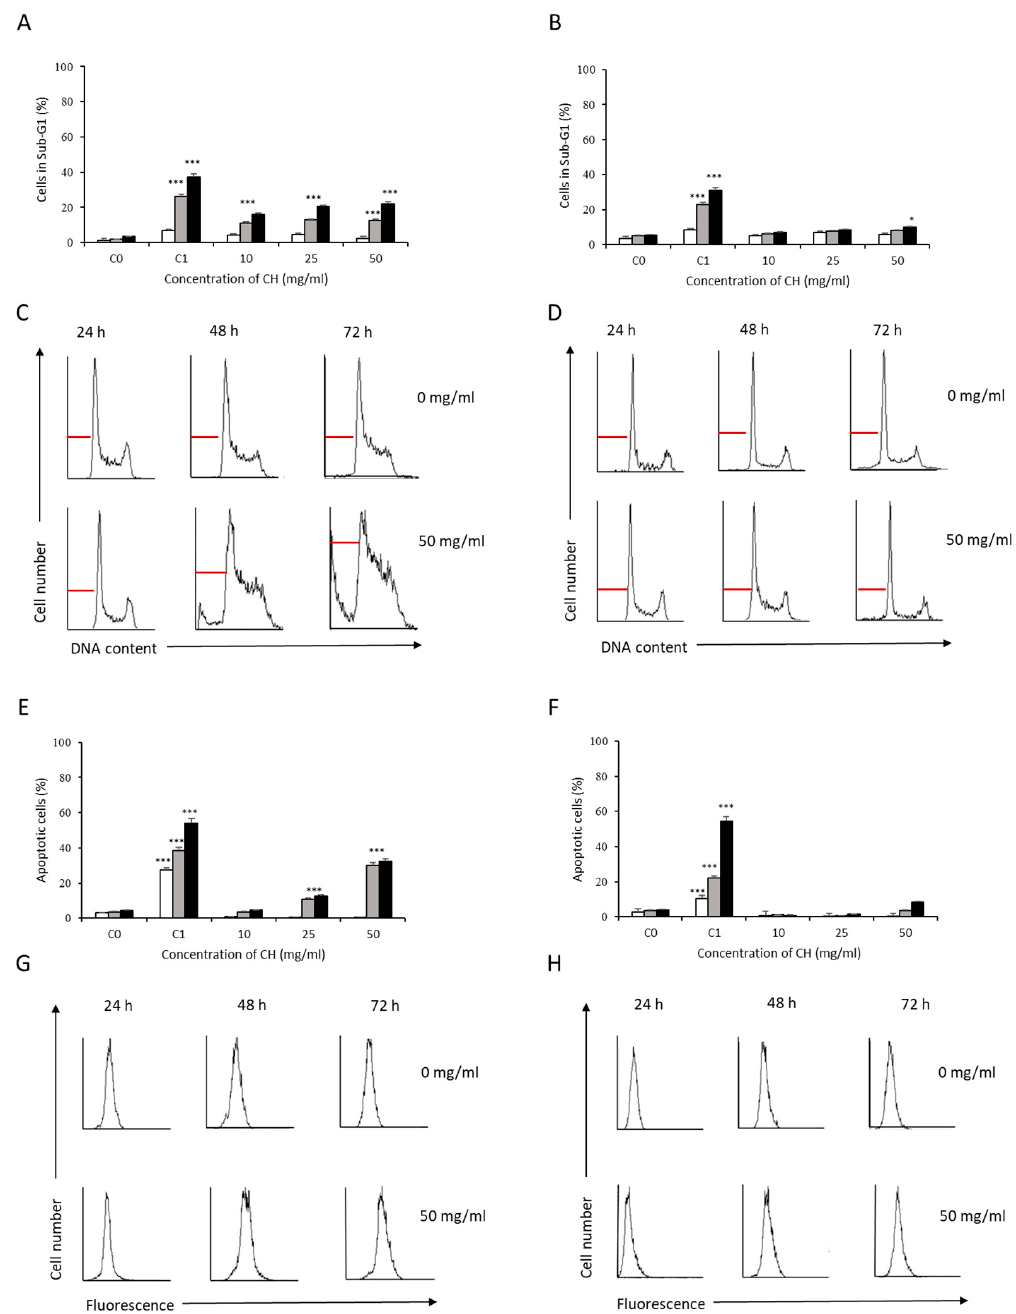
Figure 5. Effect of sample 6 (CH) on human liver cells apoptosis. The cell cycle was determined using flow cytometry. HepG2 ( A ) and WRL-68 ( B ) cells were treated with different doses of sample 6 (10, 25, and 50 mg/mL) for 24 ( □ ), 48 ( ■ ), and 72 h ( ■ ). Representative histograms of the cell cycle of HepG2 ( C ) and WRL-68 ( D ) cells are shown; the red line indicates the sub-G1 phase. The percentage of apoptosis was analyzed by flow cytometry using the TUNEL assay. HepG2 ( E ) and WRL-68 ( F ) cells were cultured with different doses of sample 6 (10, 25, and 50 mg/mL) for 24 ( □ ), 48 ( ■ ), and 72 h ( ■ ). Representative histograms of the fluorescence intensity in HepG2 ( G ) and WRL-68 ( H ) cells are presented. C 0 , untreated cells; C 1 , cells treated with etoposide (50 µM). Asterisks indicate a significant difference from the control (C 0 ). * p ≤ 0.05,*** p ≤ 0.001. Other researchers also showed the apoptotic potential of honey in human hepatoma Comparing both monofloral honey samples, sample 6 (CH) obtained better results: cancer cells. Al Refaey et al. demonstrated that manuka honey at a concentration of 3.46% at 50 mg/mL, it induced 30% (48–72 h) apoptosis, and sample 1 (TH) did not reach